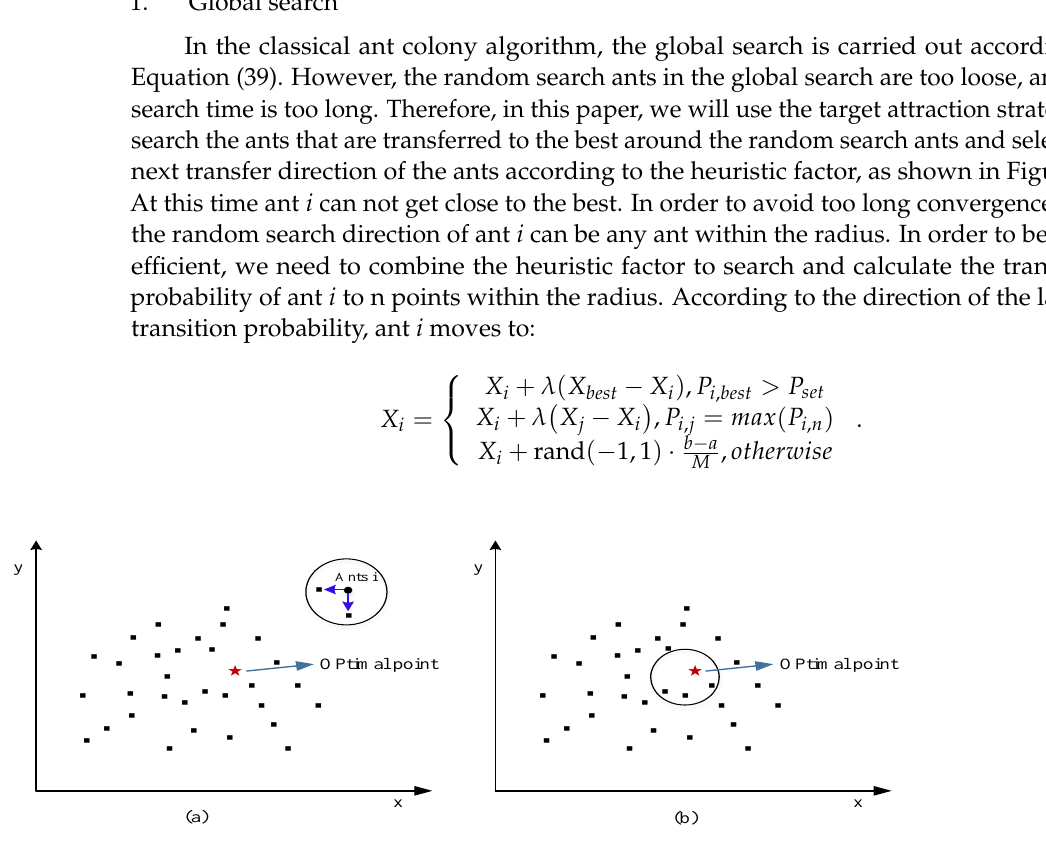
Figure 6. ( a ) Schematic diagram of random search path selection of ants. ( b ) Schematic diagram of ant local search path selection.